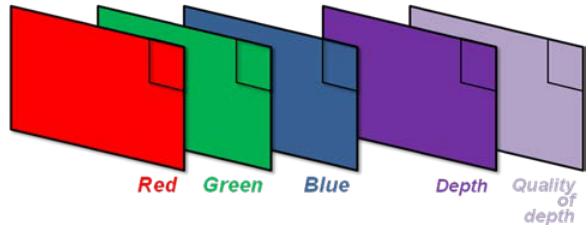
Figure 2. Adding a depth and quality layer to image data in order to obtain a Depth Cyclorama